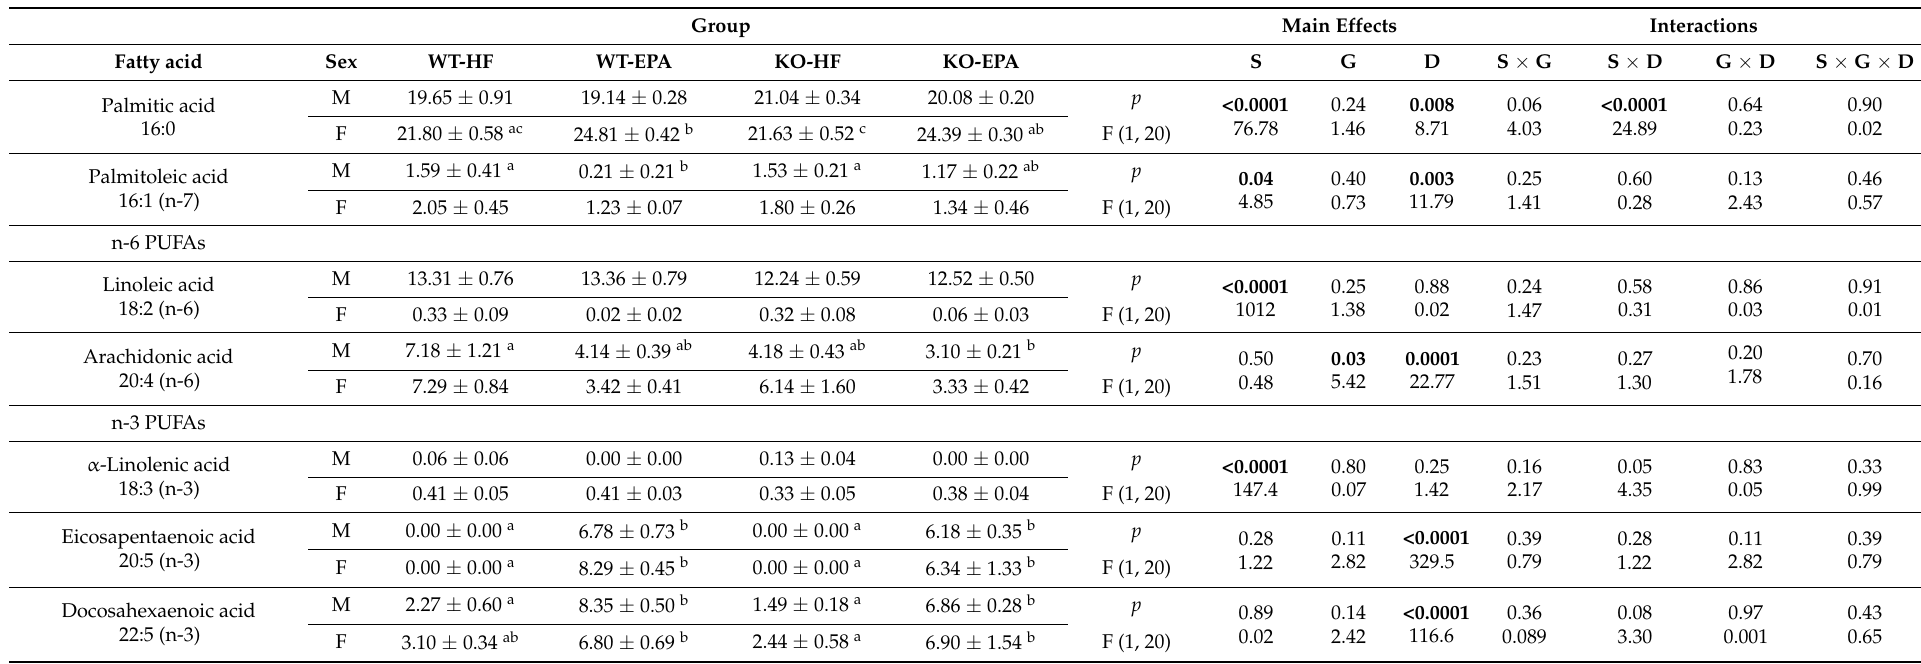
Table 2. Fatty acid composition (%) of liver tissue in male and female mice from each